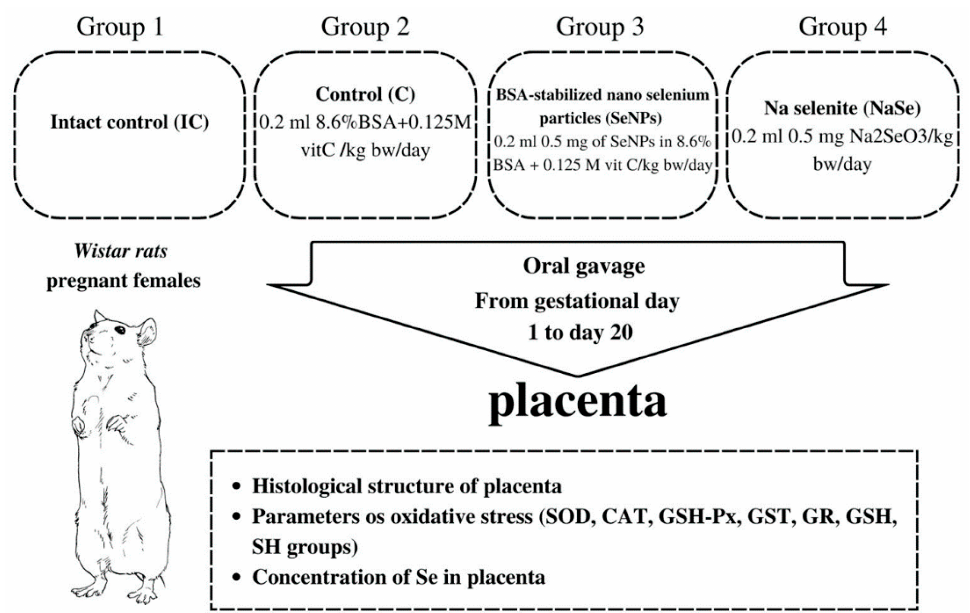
Figure 7. Schematic of the experimental